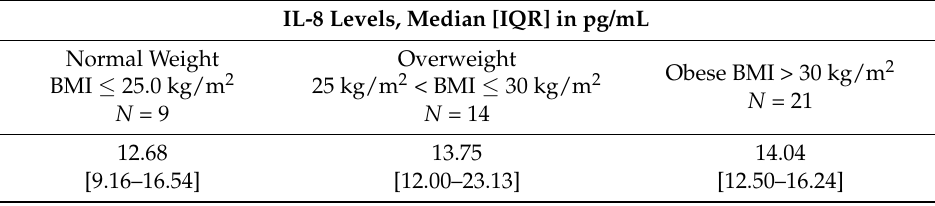
Table 3. Comparison of IL-8 plasma levels in T2DM patients according to their